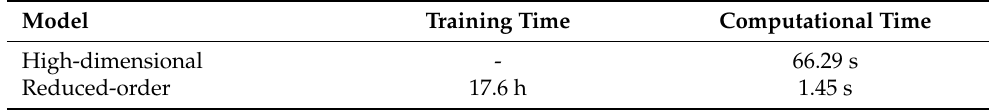
Table 6. Computation time for high-dimensional and reduced-order